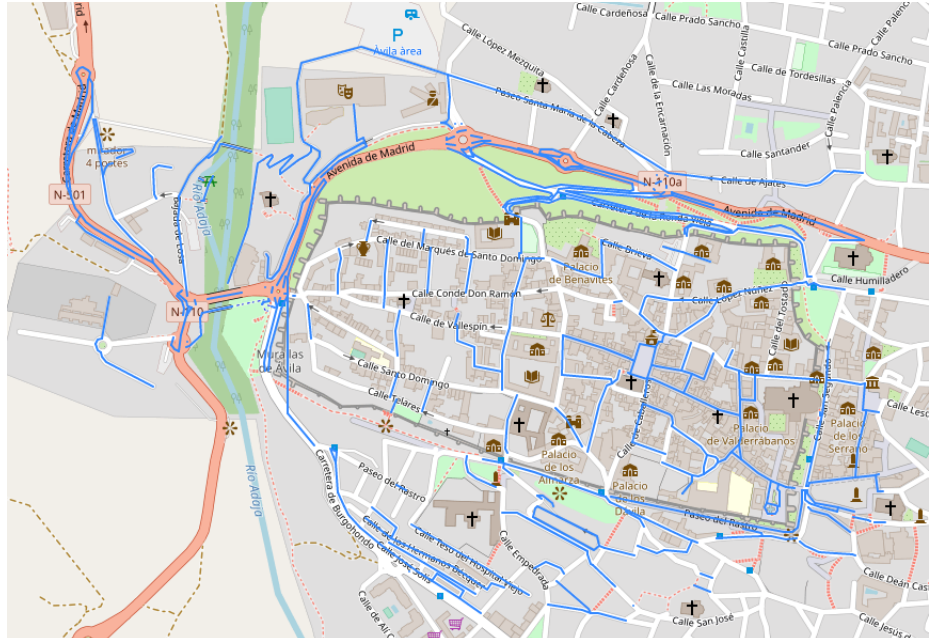
Figure 2. Accessible streets. In blue, we show all streets that are accessible to everyone, regardless of their mobility. This map of the city represents the accessible streets (correspond with the green level color in Table 3) after removing the inaccessible streets for a person with high mobility restrictions is presented.